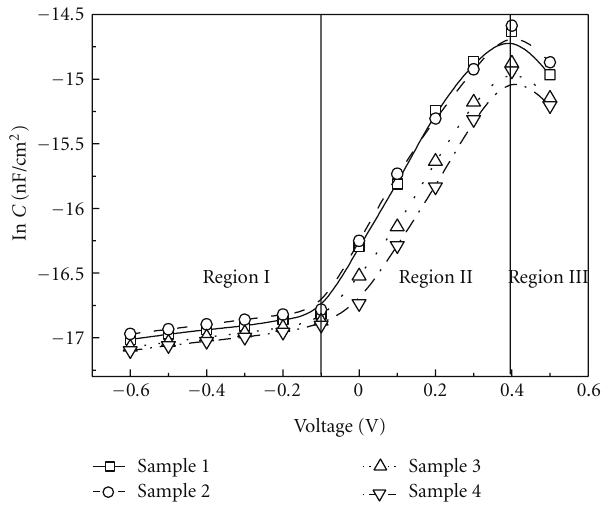
Figure 9: The measured capacitance ( C 1 ) as a function of bias voltage in the p-i-n